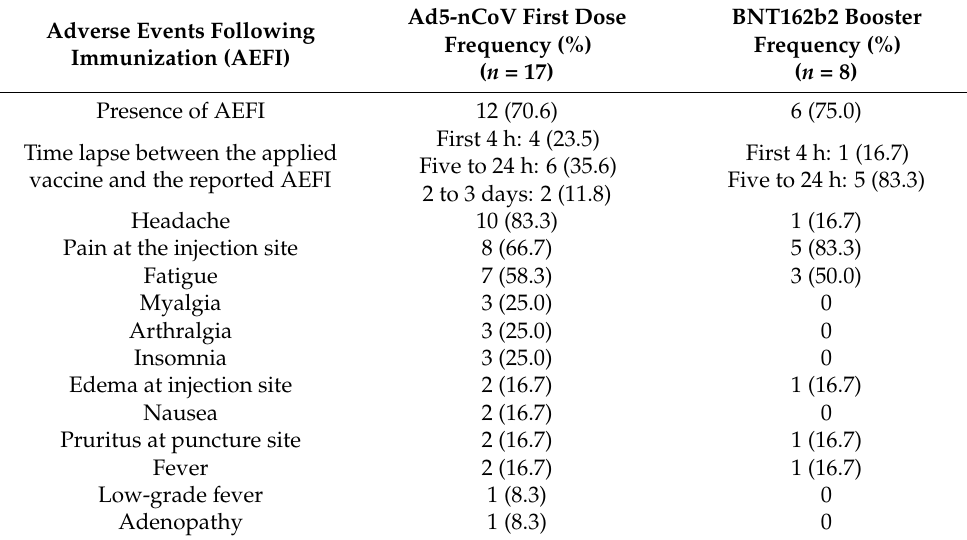
Table 3. Adverse events in relation to